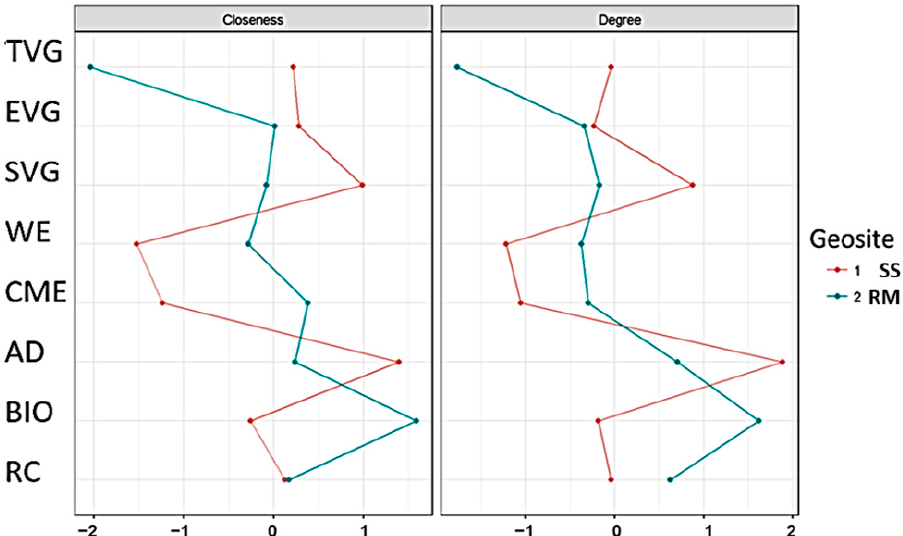
Figure 17. Measures of centrality of the variables of the Ecosystem’s Health Provision Spectrum of Santo Sepulcro and Riacho do Meio, Araripe UGG. Subtitle: 1. SS: Santo Sepulcro; 2. RM: Riacho do Meio. TVG: Touristic Value of Geodiversity; EVG: Educational Value of Geodiversity; SVG: Scientific Value of Geodiversity; WE: Wellness Experience; CME: Climatic and Meteorological Exposure; AD: Aquatic Diversity; BIO: Biodiversity; RC: Route Classification.